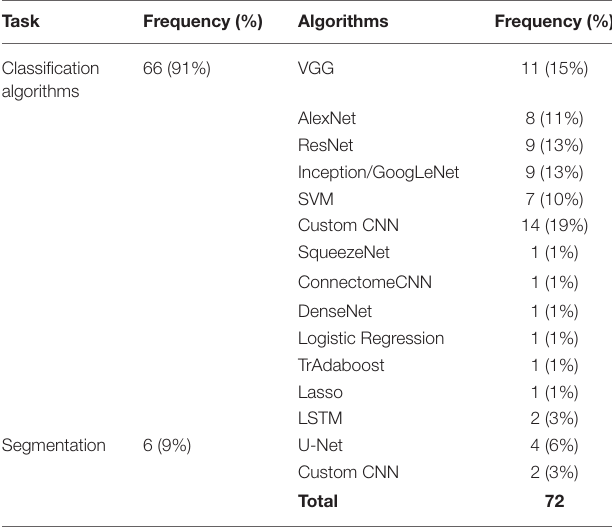
TABLE 3 | Different algorithms used for neuroimaging problems and their usage frequency.